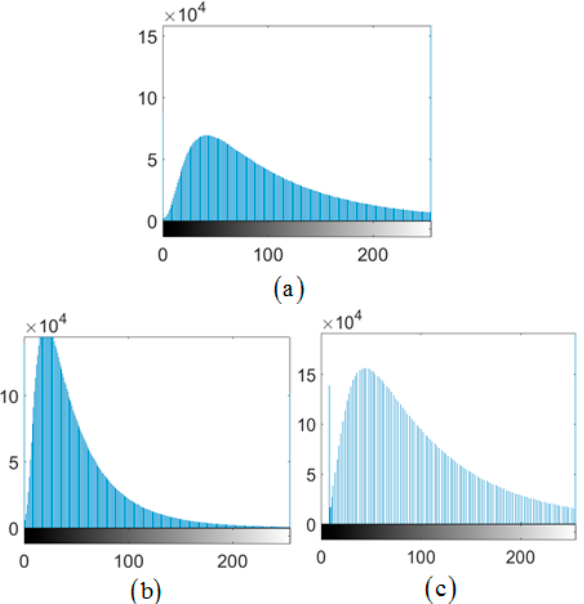
Figure 13. The grey scale histogram. ( a ) The grey scale histogram of Figure 12a. ( b ) The grey scale histogram of Figure 12b. ( c ) The grey scale histogram of Figure 12c.